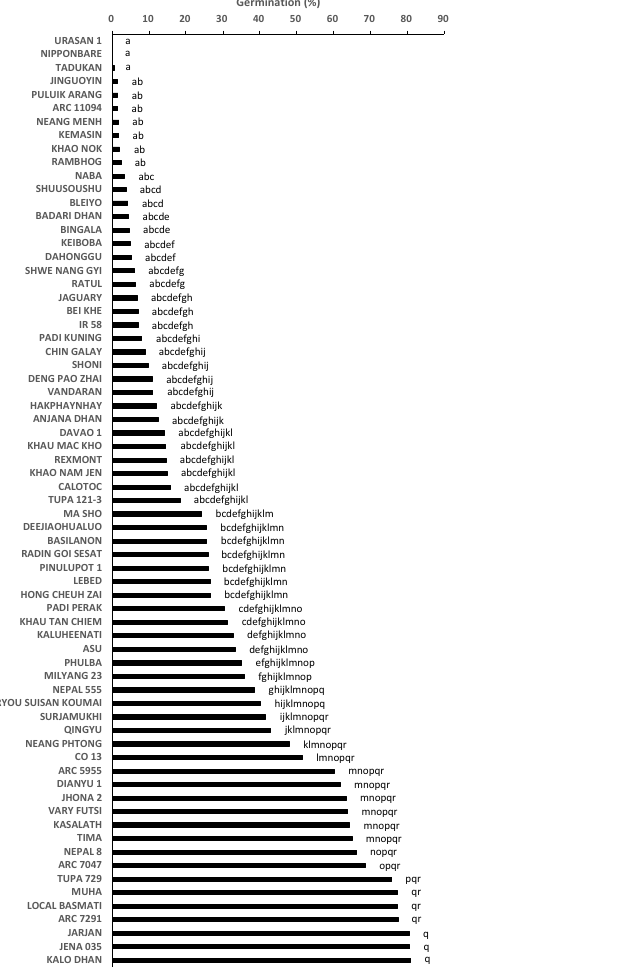
Figure 1. Germination-inducing activity of root exudates (pre-attachment resistance) of 69 accessions in World Rice Core Collection. The percentage values were arcsine transformed, compared by multiple mean-separation tests among the accessions and back-transformed. Means followed by a common letter are not significantly different by Tukey’s HSD test ( p < 0.05). The synthetic strigolactone GR24 was used at 0.34 µ M as a positive control, and tap water was used as a negative control, which induced 54.1–89.2% and 0.0–3.1% germination, respectively.